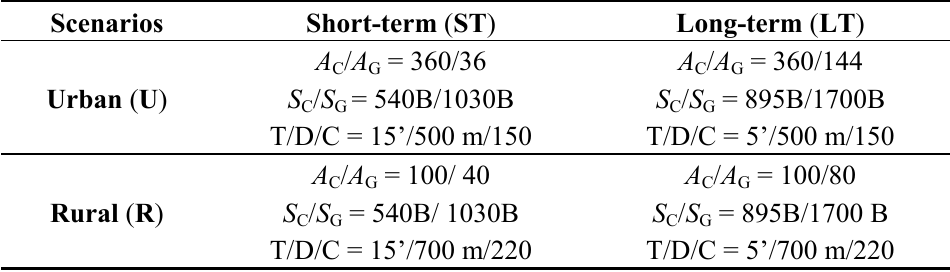
Table 3. Summary of the most important parameters in each